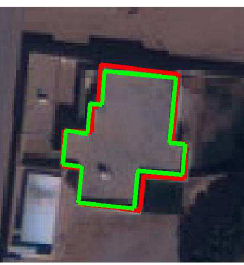
Figure 8. Building feature mapped with aerial and satellite imagery